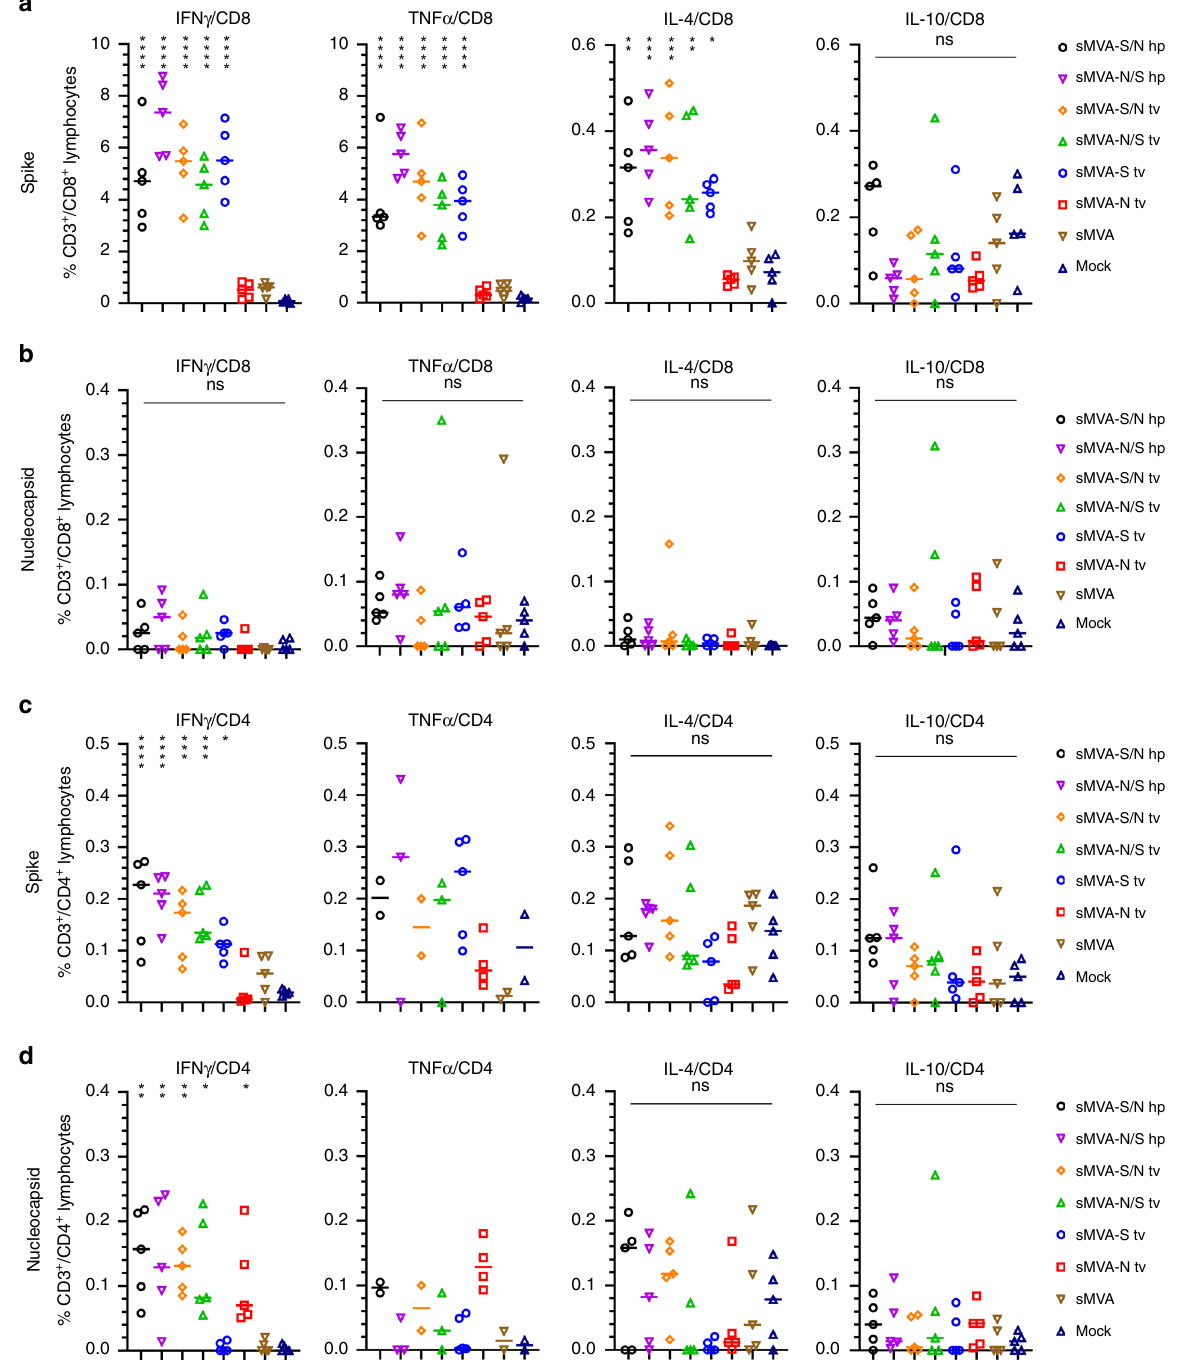
Fig. 6 Cellular immune responses stimulated by sMVA-CoV2 vectors. Balb/c mice ( n = 5) immunized twice in a 3-week interval with 5 × 10 7 PFU of the single or double recombinant sMVA-CoV2 vectors derived with FPV HP1.441 (sMVA-S/N hp and sMVA-N/S hp) or TROVAC (sMVA-S/N tv, sMVA-N/S tv, sMVA-S tv, sMVA-N tv) were evaluated for SARS-CoV-2-speci fi c cellular immune responses. Antigen-speci fi c CD8 + ( a and b ) and CD4 + ( c and d ) T- cell responses induced by the vaccine vectors after two immunizations were evaluated by fl ow cytometry for IFN γ , TNF α , IL-4, and IL-10 secretion following ex vivo antigen stimulation using SARS-CoV-2 S- and N-speci fi c peptide libraries. Due to technical issues, 1 – 3 animals/group were not included in the CD4/TNF α analysis in c and d . One-way ANOVA with Tukey ’ s multiple comparison test was used to compare % of cytokine-speci fi c T cells between immunized mice and mock controls. Lines represent median values; *0.05 < p < 0.01, **0.01 < p < 0.001, ***0.001 < p < 0.0001, **** p < 0.0001; ns = not signi fi cant. Source data are provided as a Source Data fi